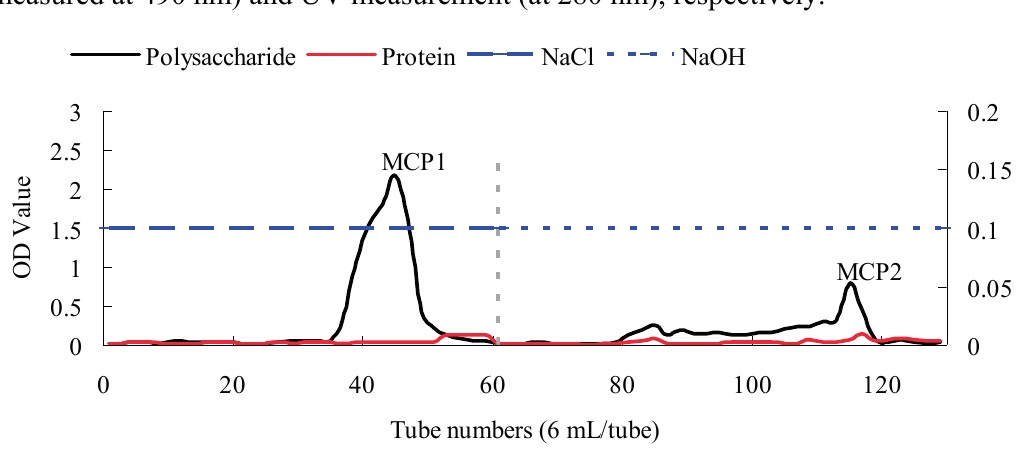
Figure 2. DEAE-52 cellulose anion-exchange chromatogram of the elution of crude polysaccharides from M. charantia polysaccharides using 0.1 mol/L NaCl and 0.1 mol/L NaOH. Polysaccharides and protein were detected using the phenol-sulphuric acid method (measured at 490 nm) and UV measurement (at 280 nm),